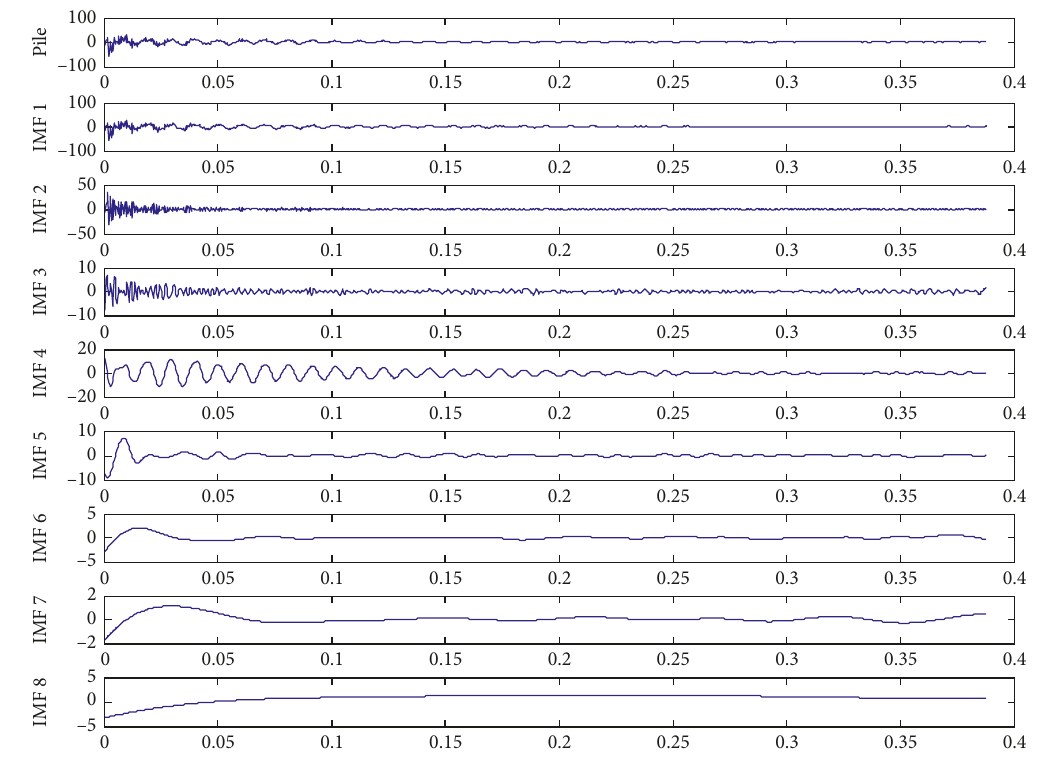
Figure 5: Decomposed components of a measured acceleration